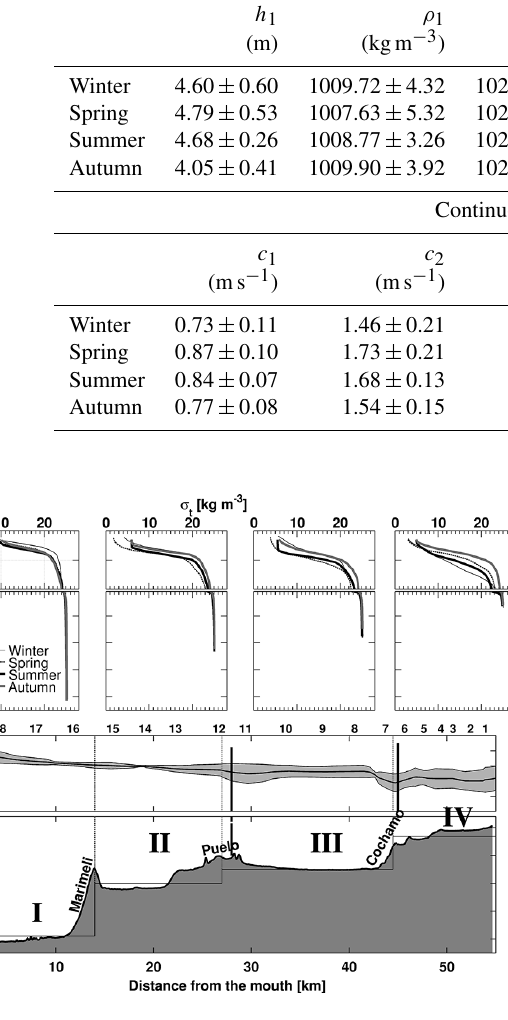
Figure 2. Seasonal profiles of density and bathymetry of the region. The upper panel shows the seasonal mean density profiles in each sub-basin of the fjord (a–d) . In the panel below (e) , the along-fjord bathymetry and sub-basin nomenclature are shown. The black line represents the mean pycnocline depth, and corresponding standard deviations are represented by the gray